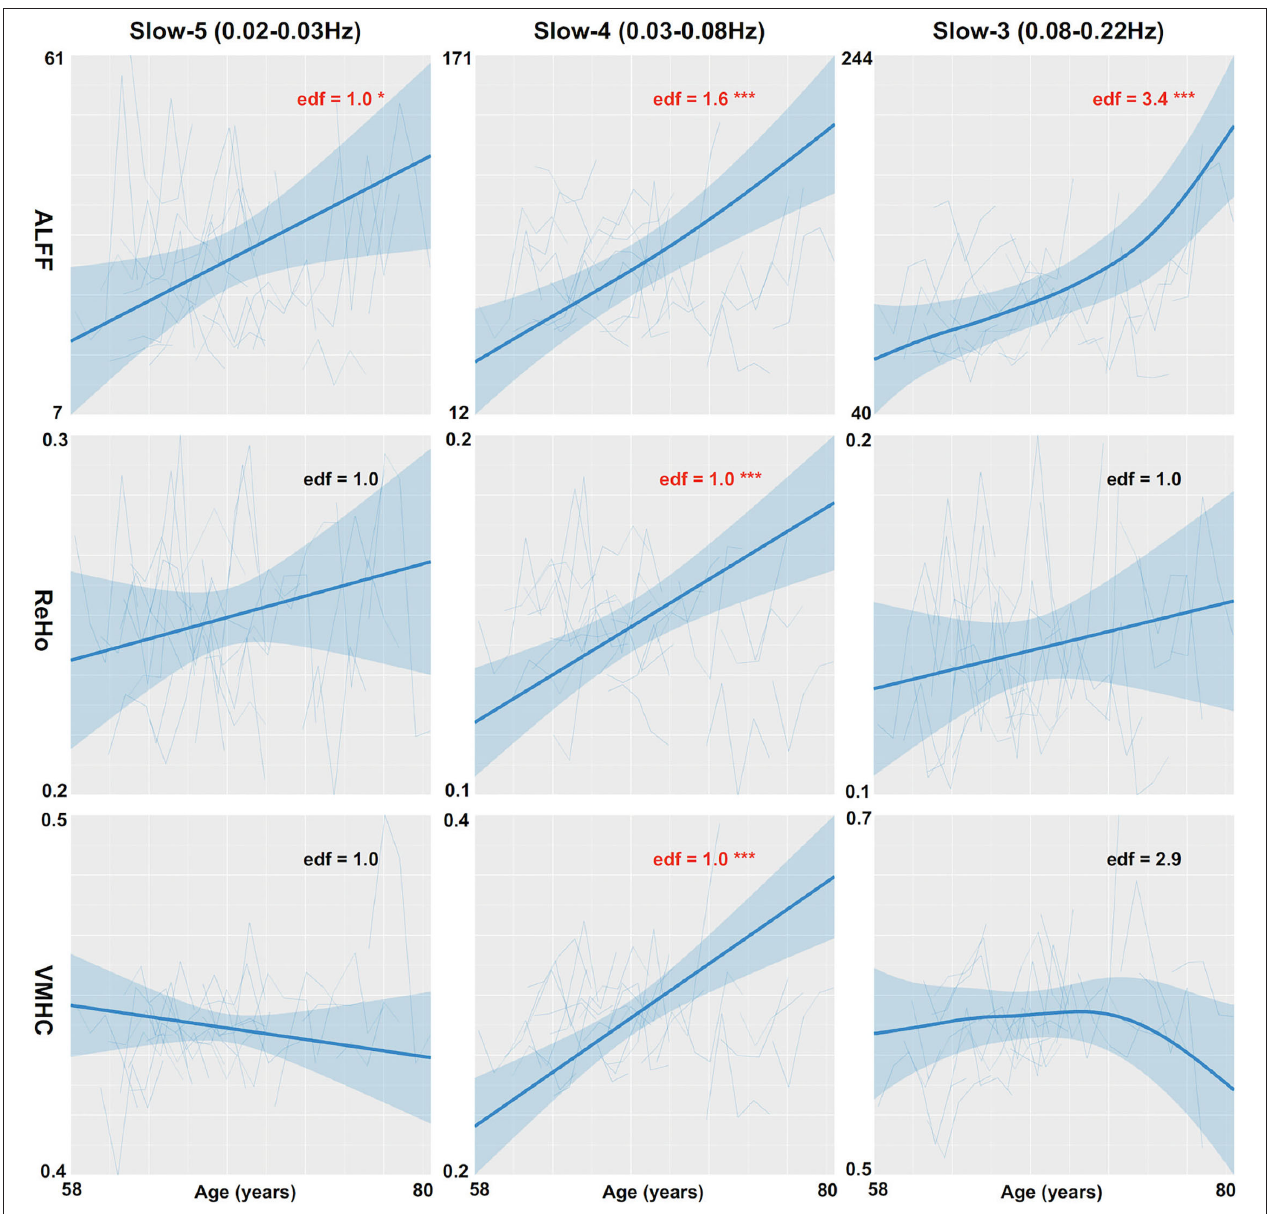
FIGURE 2 | Global variability measurements of CSA are regressed against age. Three CSA metrics including ALFF (the top row), ReHo (the middle row), and VMHC (the bottom row) are plotted for each individual and modeled into the aging curves with the 95% CI (the shadow areas). The aging curve modeling are applied to three different frequency bands including slow-5 (the left column), slow-4 (the middle column), and slow-3 (the right column). edf: effective degree of freedom; * p < 0.05; ** p < 0.01; *** p < 0.001.